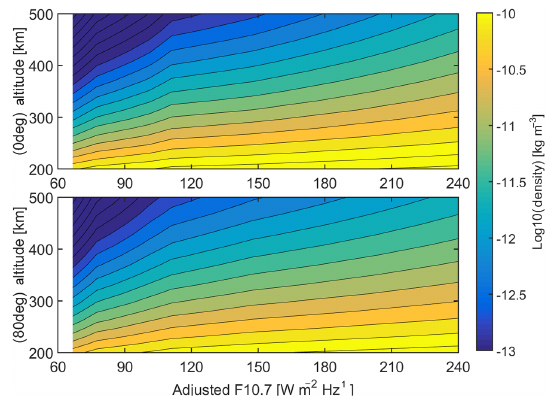
Figure 8. Comparison of neutral density as a function of time from GITM simulations (solid black line), CHAMP flight data (solid grey line) and semi-empirical models (dashed line).